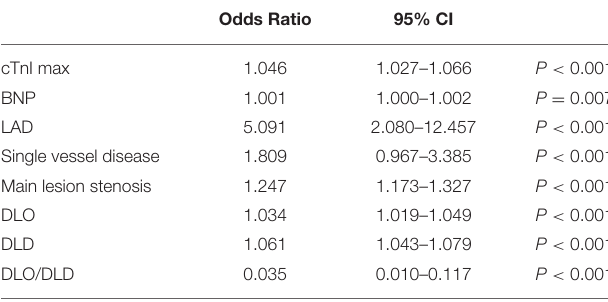
TABLE 3 | Binary logistic regression analysis of factors related to the formation of